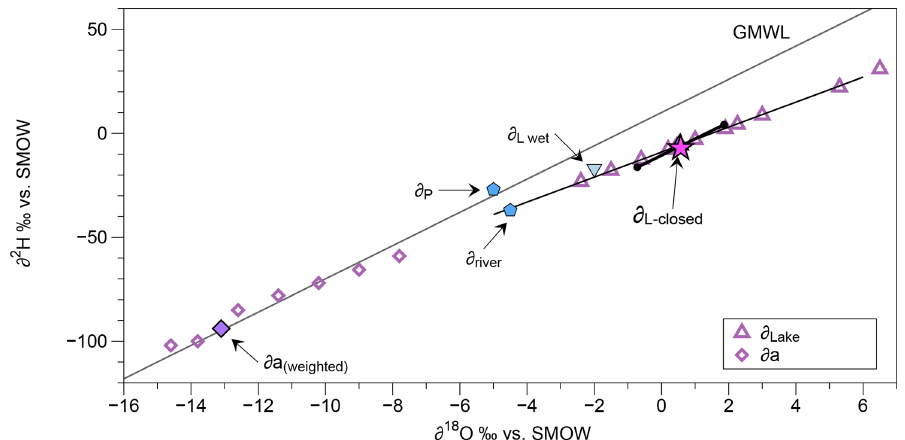
Figure 6. Representation of δ L − closed for Lake Ihotry. Purple triangles represent Lake Ihotry isotopic composition over a year, and the purple diamonds are the atmospheric isotopic composition ( δa ) over a year (the solid one represents the δa -weighted average). δP is the rainfall isotopic composition above Lake Ihotry and δ river is the isotopic composition of the Befandriana River which feeds Lake Ihotry. The pink star represents the δ L − closed , calculated according to Eq. (6). The blue triangle is the δ L − wet , calculated using Eq. (9). The black line around δ L − closed represents the associated